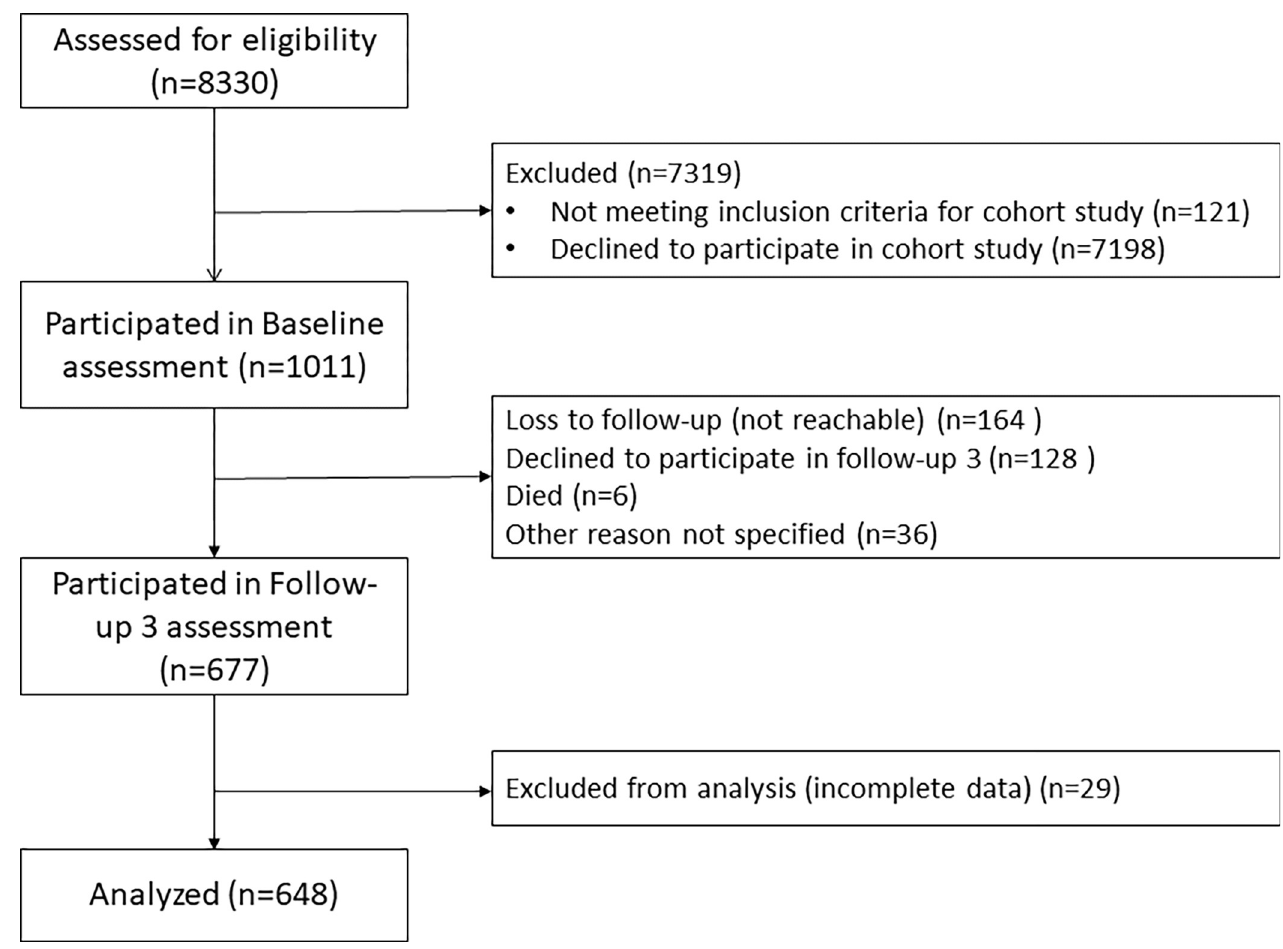
Fig 1. Flow diagram for inclusion of participants in the current